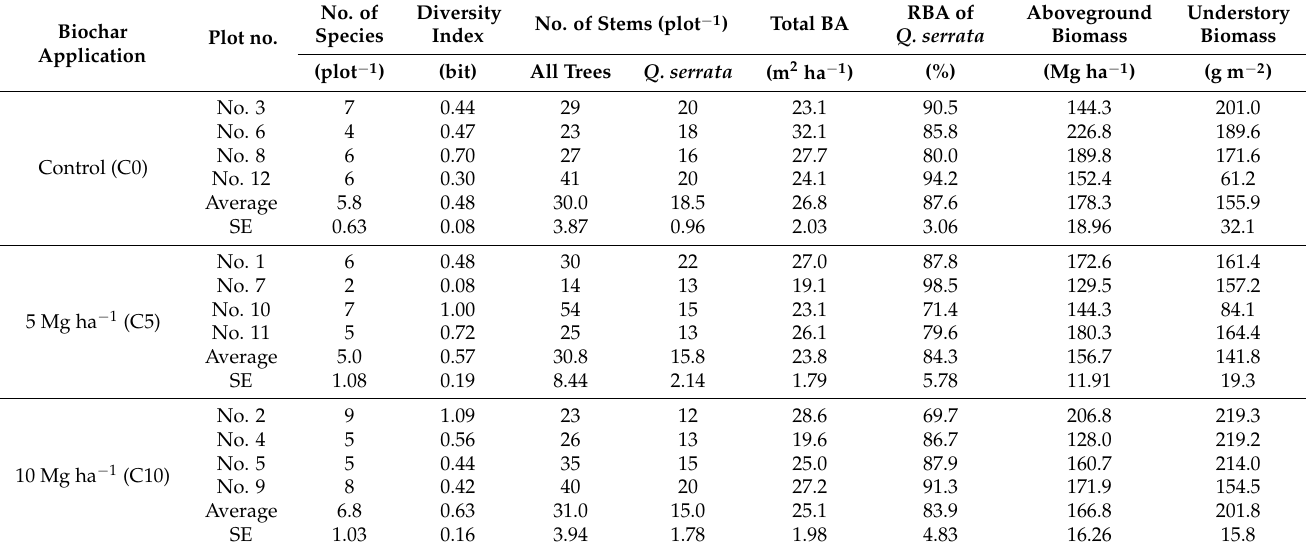
Table 1. Community structures and attributes of the experimental plots in an oak ( Q. serrata ) forest prior to biochar application. All tree stems with a height ≥ 1.3 m were measured in each plot (20 m × 20 m). Biochar Plot no. Application